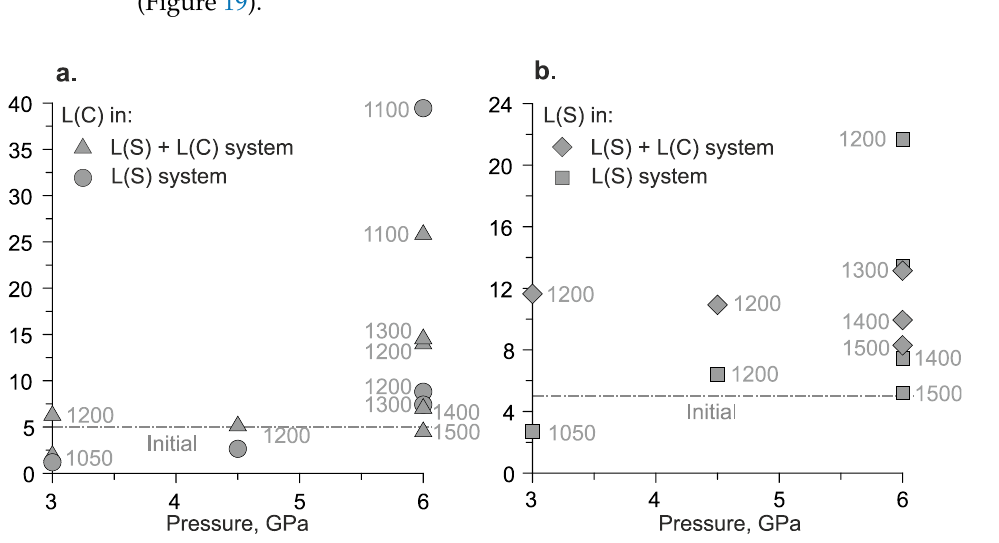
Figure 19. K 2 O/Na 2 O weight ratio in carbonate ( a ) and silicate ( b ) melts versus pressure. The gray numbers are temperatures in °C.